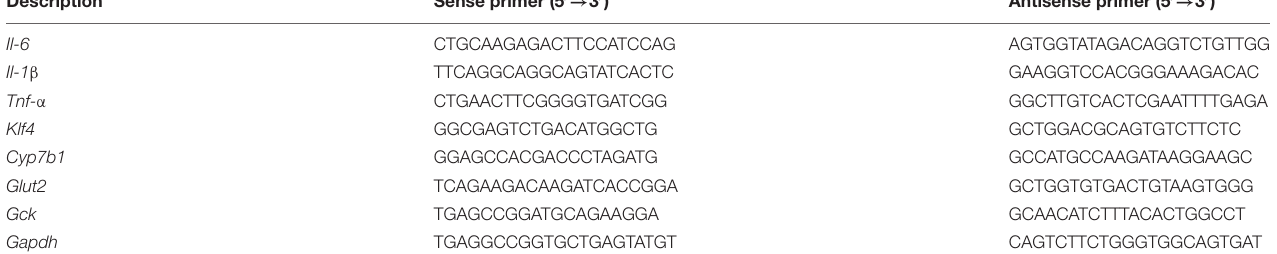
TABLE 1 | The primers used in this study for real time PCR. Description